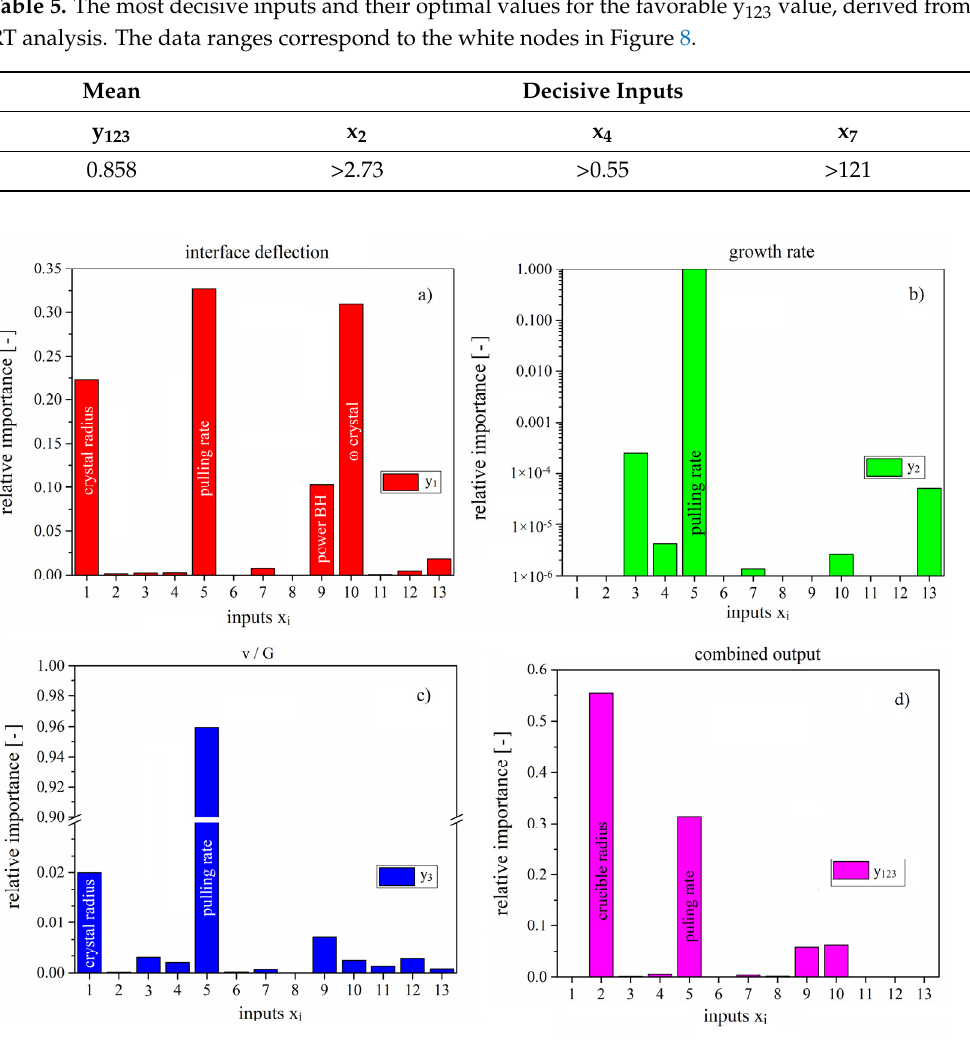
Figure 9. Relative importance of the inputs for: ( a ) interface deflection y 1 , ( b ) crystal growth rate y 2 , ( c ) ratio of growth rate and axial temperature gradient in the crystal y 3 , and ( d ) combined normalized output y 123 .